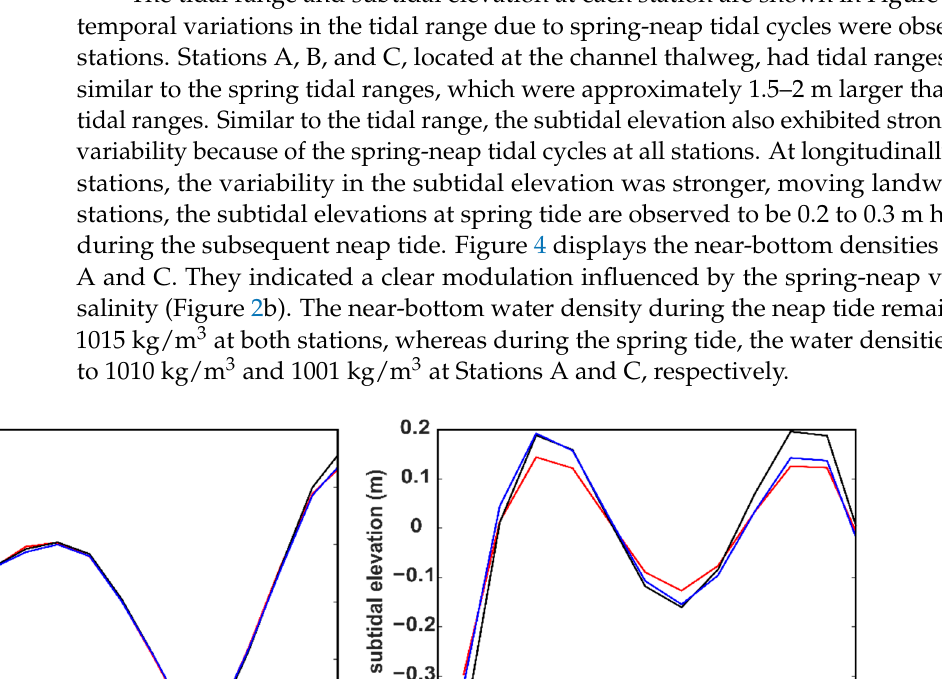
Figure 4. Water densities at Stations A and C.